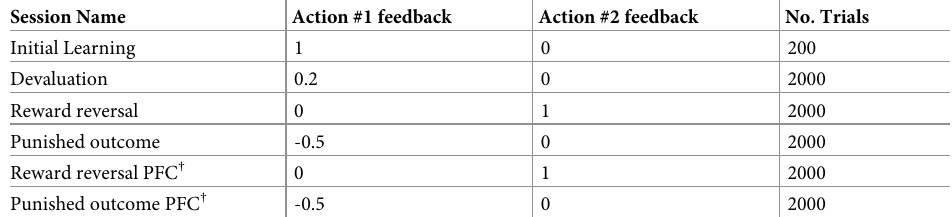
Table 4. Behavioral sessions were defined by the organization of reward